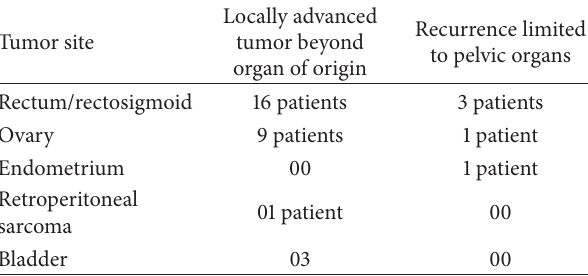
Table 1: Cross tabulation of tumor site and indication for exentera-